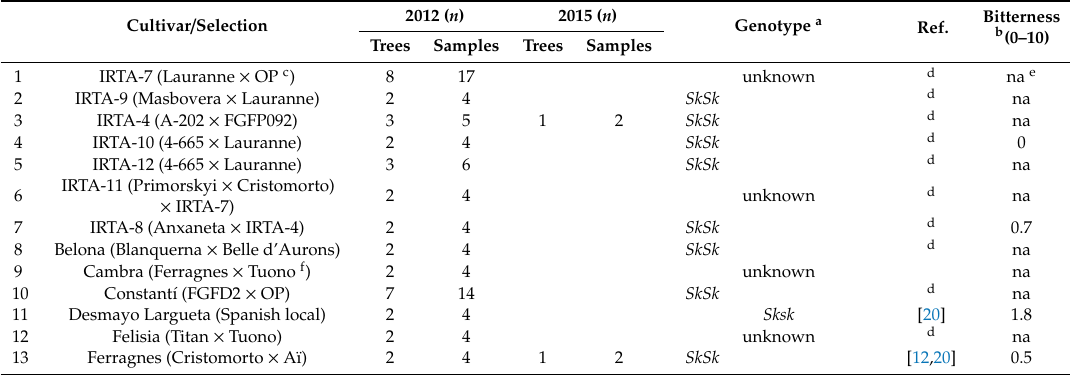
Table 1. Almond samples’ pedigrees, harvesting year, tree and sample number, Sk genotype and bitterness. 2012 ( n ) 2015 ( n ) Genotype a Cultivar / Selection